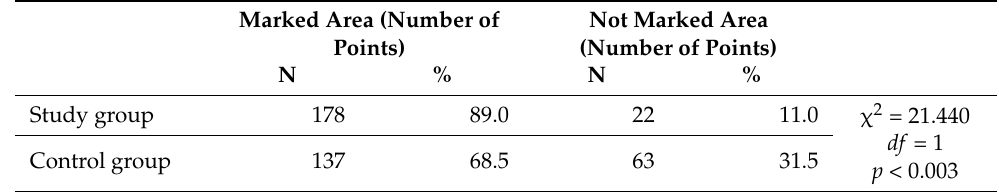
Table 5. In the proprietary interactive tactile test “breast self-examination”, the amount of marked area—Test